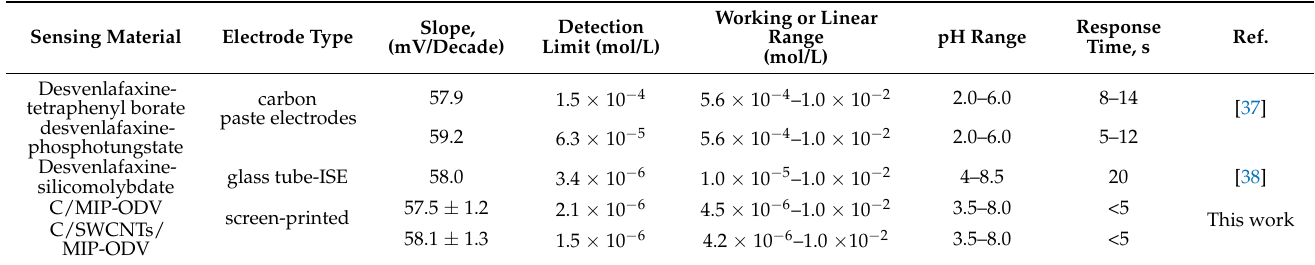
Table 1. Overview on the reported potentiometric sensors of ODV